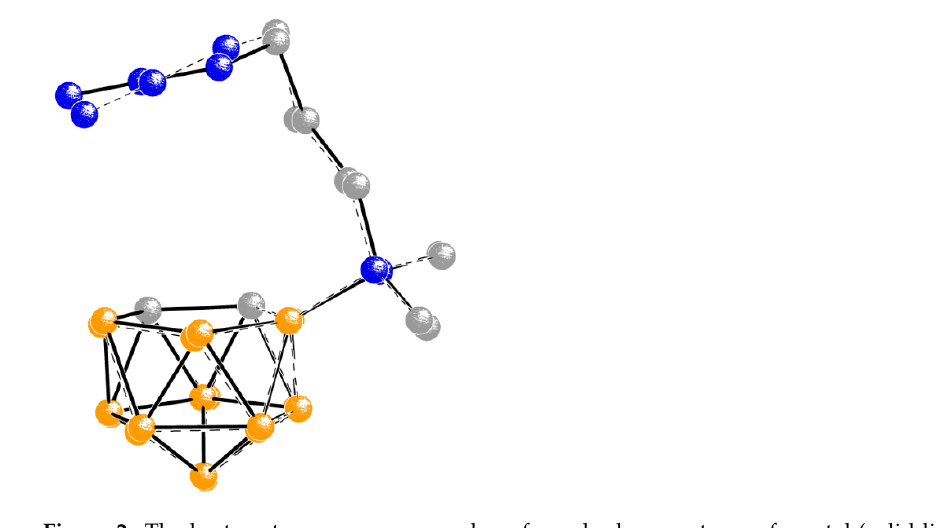
Figure 2. The best root-mean-square overlap of non hydrogen atoms of crystal (solid lines) and isolated (dashed lines) structures of 2 .